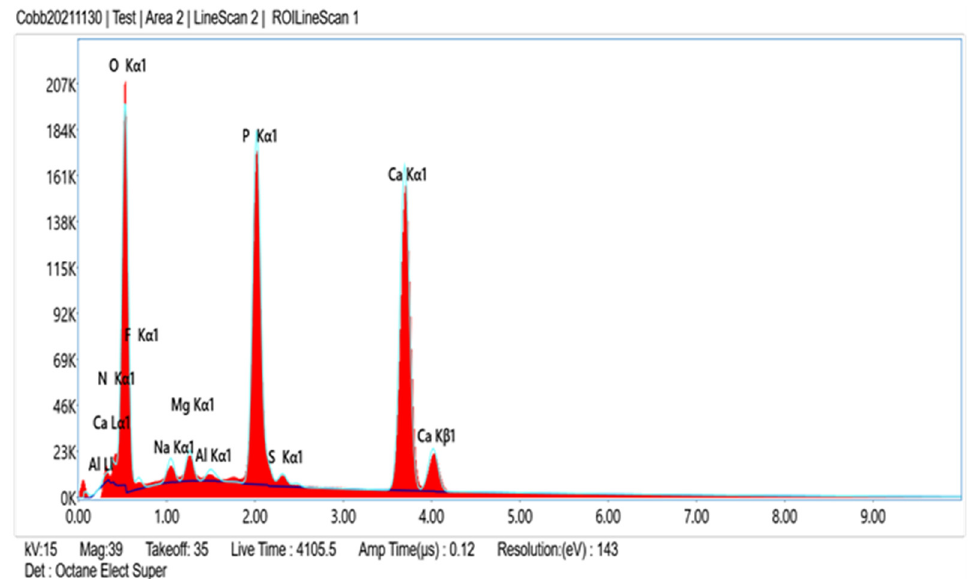
Figure 12. Conversion of the line scan seen in Figure 11 to an EDS spectrum shows relative peak height of the various elements of interest. As with the SRP-only specimen (Figure 10), the dominate peaks are O, P, and Ca, with lesser peaks for N, F, Na, Mg, and S.